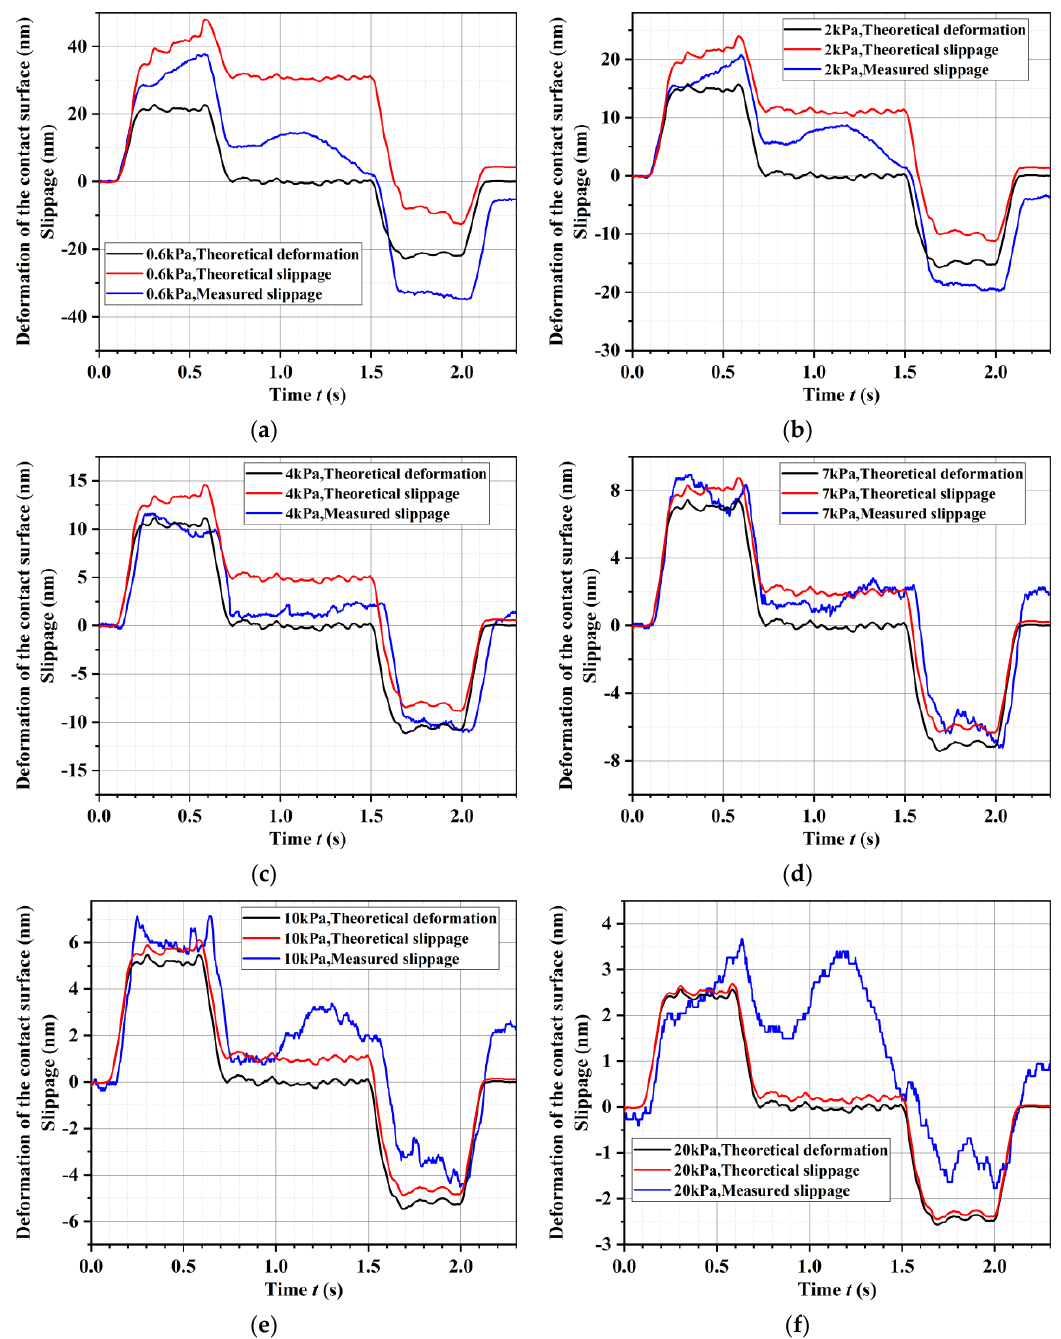
Figure 10. Deformation of contact surfaces, theoretical slippage, and measured slippage for vacuum degrees of ( a ) 0.6 kPa; ( b ) 2 kPa; ( c ) 4 kPa; ( d ) 7 kPa; ( e ) 10 kPa; and ( f ) 20 kPa. When the reticle stage reached the steady acceleration phase (0.25 s~0.6 s) from static (0.0 s), we measured the average slippage between the reticle and the chuck for suction- cup vacuum degrees of 0.6 kPa, 2 kPa, 4 kPa, 7 kPa, 10 kPa, and 20 kPa, as shown in Table